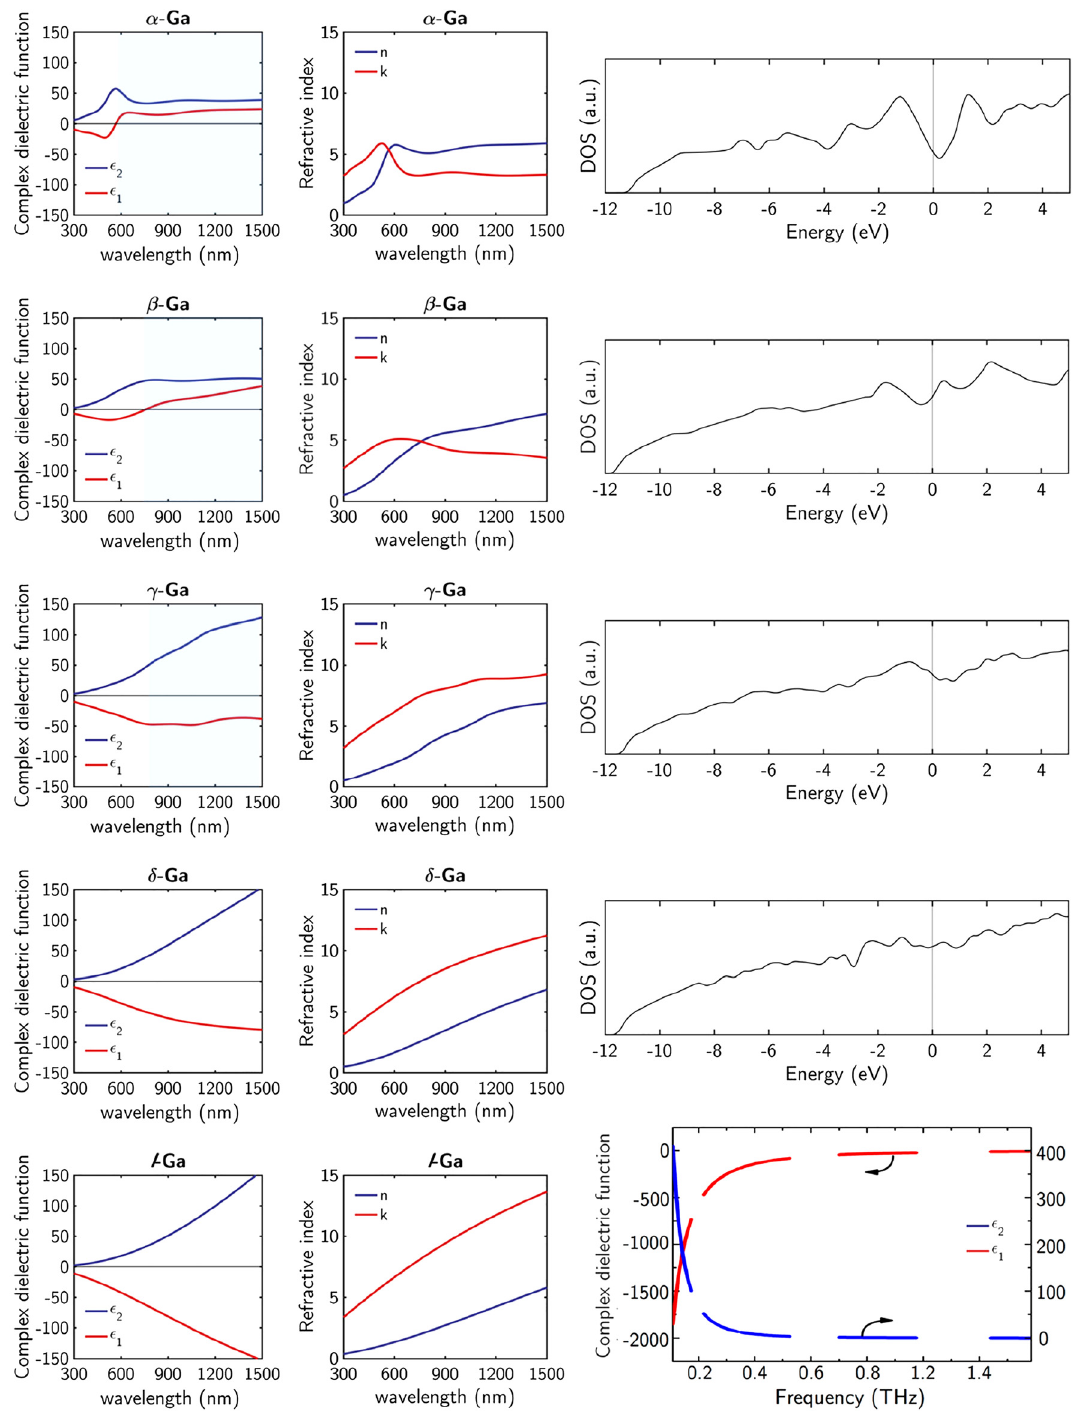
Figure 3: Complex dielectricfunction ( ε = ε 1 + i ε 2 ), complexrefractive index ( N = n + ik ), and densityof states(DOS) of α -, β -, γ -, and δ -Ga.The experimental complex dielectric function and refractive index of liquid gallium ( l -Ga) measured by spectroscopic ellipsometry in the UV-NIR and in the THz range is also functions to the model dielectric function to effectively modi fi cations to the classical Drude model have been reduce the conductivity in those ranges. Indeed, the Drude proposed to account for the Drude deviation in the THz model constants should be redetermined in the THz range range, typically by modifying amplitude oscillator